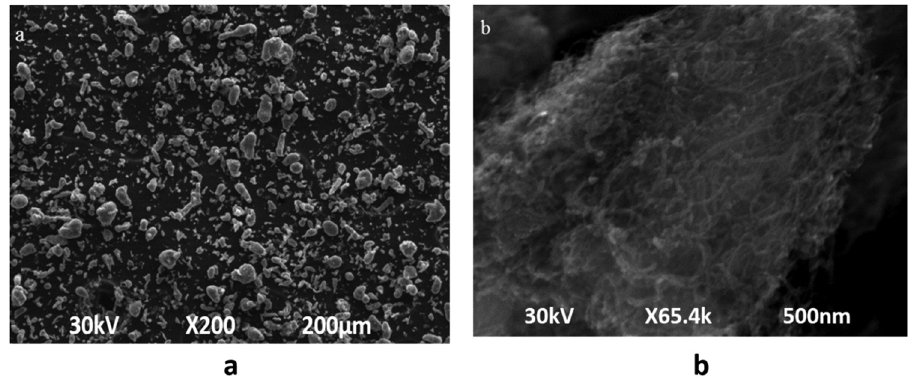
Figure 3: ( a ) SEM of Al – Cu – Mg – T351 Al powder and ( b ) SEM image of CNT powder ( MWCNT ) .